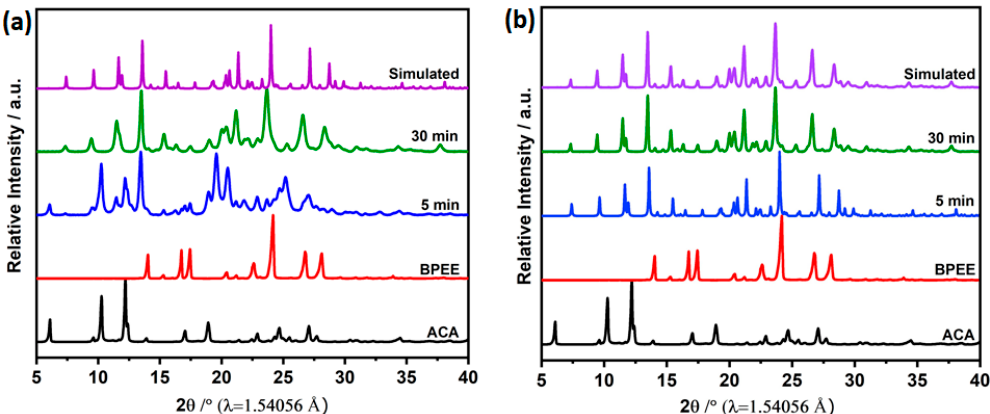
Figure 2. Powder X-ray di ff reaction (PXRD) patterns of 9-anthracenecarboxylic acid (ACA), 1,2-bis(4-pyridyl)ethylene (BPEE), and the mechanochemically synthesized ACA-BPEE cocrystal with respect to the di ff erent time intervals with ( a ) neat grinding (NG) and ( b ) liquid-assisted grinding (LAG) with MeOH.